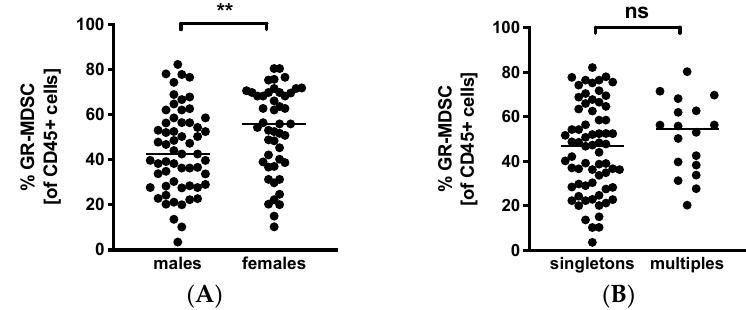
Figure 4. Quantification of GR-MDSC in breast milk of preterm infants (infant characteristics). Milk cells were isolated from the breast milk of mothers of preterm infants during the first five weeks of life. Percentages of GR-MDSC of total CD45 + leucocytes were determined by flow cytometry. The mean percentage of GR-MDSC was calculated. A + B Scatter diagrams showing the expression of GR-MDSC in breast milk of mothers of female and male infants ( A ) and singletons and multiples ( B ). n = 18–68, ** p < 0.005, ns not significant, Mann–Whitney test.